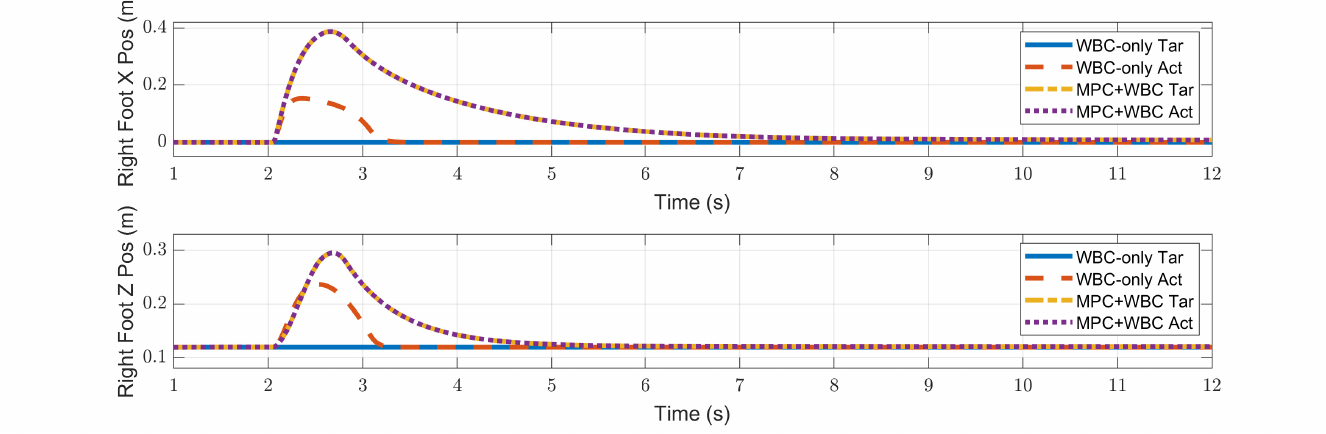
Figure 6. Swing foot position of the robot under the frontal impact of a 9 kg rigid